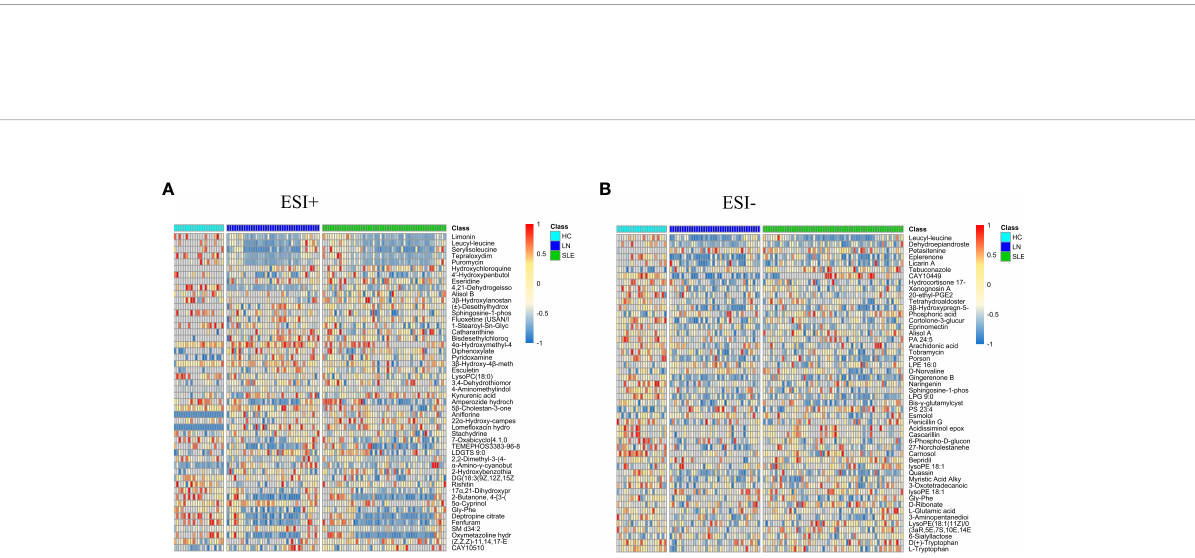
FIGURE 3 Heat maps of differential metabolites in positive (A) and negative (B) modes. The columns represent samples, the rows represent metabolites, and the relative content of the metabolites is displayed by color. The heat map shows differential metabolites among HC, SLE and LN groups. HC, healthy controls; SLE, Systemic lupus erythematosus; LN, Lupus